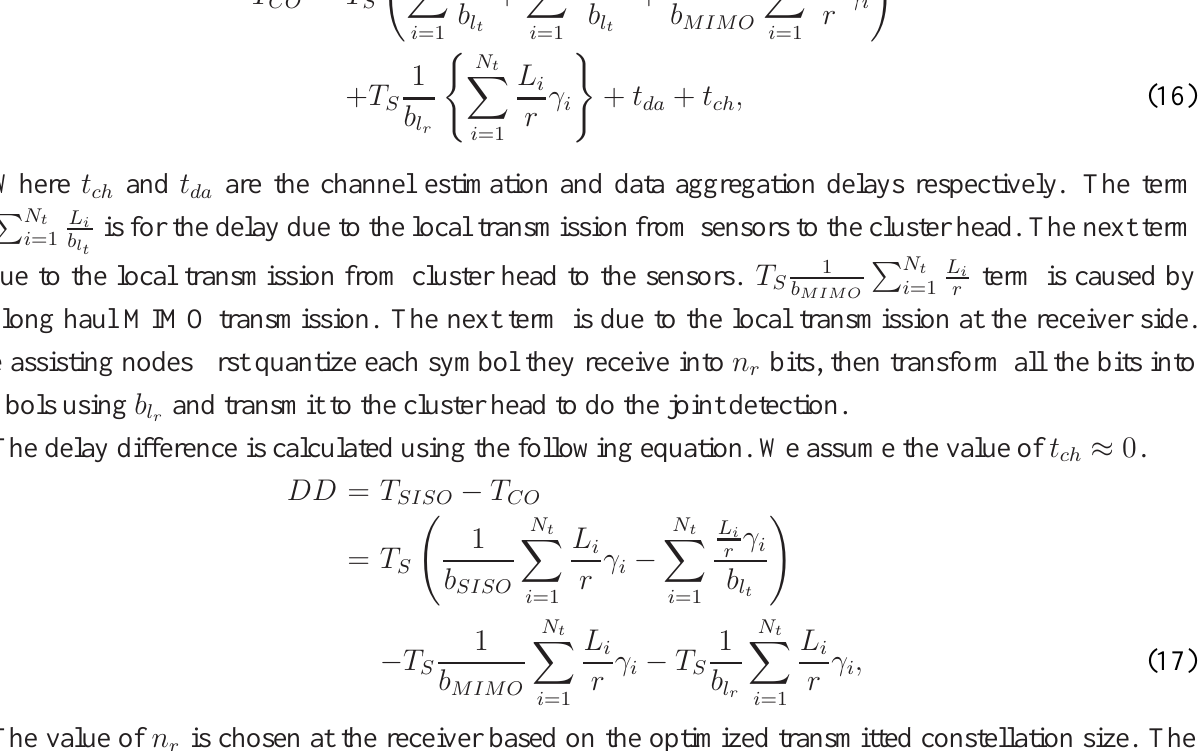
Figure 7. Delay difference over distance for code rate r = 3